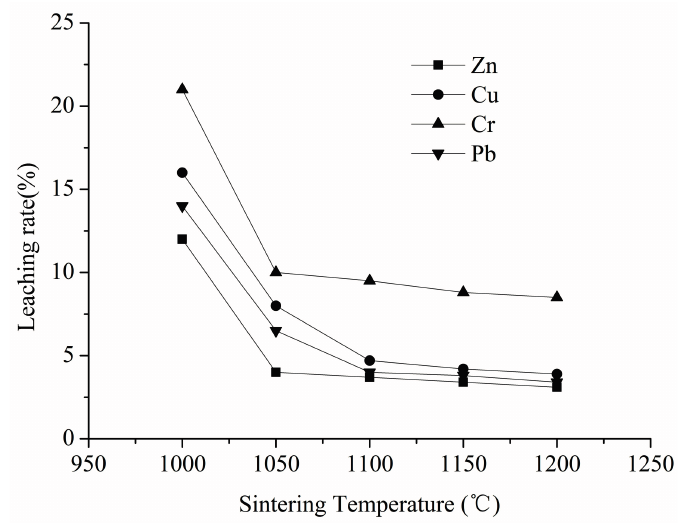
Figure 4. Effect of sintering temperature on the leaching rate of heavy metals.